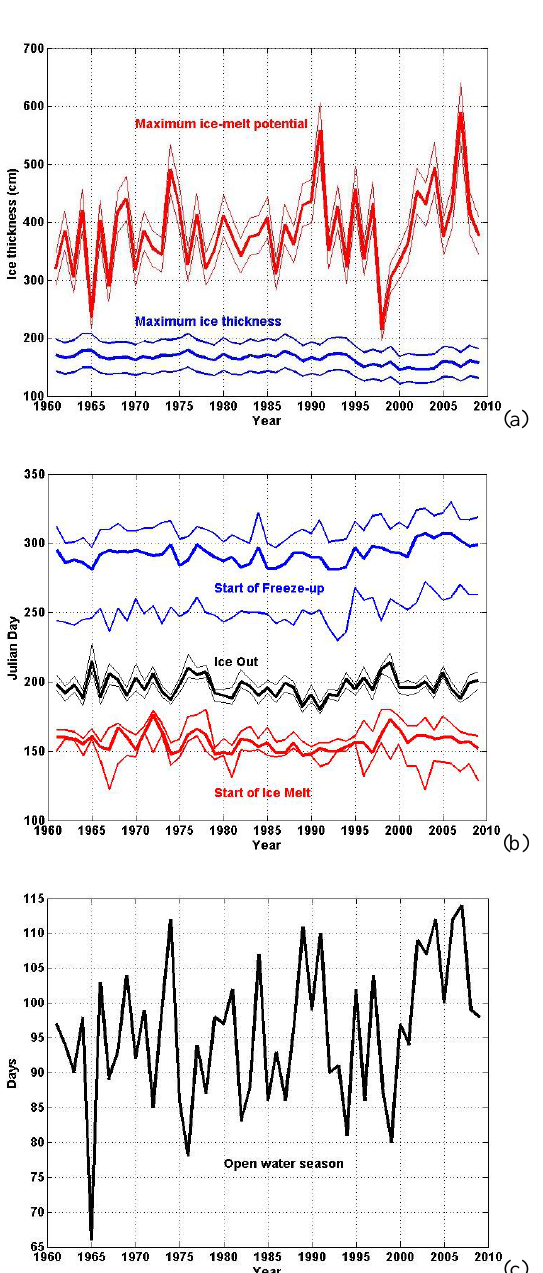
Fig. 6. Model output for the NNR record 1961–2009. In (a) , max- imum ice melt potential and ice thickness are shown (thick lines) with parameter uncertainties (thin lines) as described in the text. In (b) , dates of initial freeze-up, ice melt, and ice-out are shown (thick lines) with parameter uncertainties (thin lines) as described in the text. In (c) , the model open water season length in shown, indicat- ing that there is usually at least 3 months of ice-free water in the modern